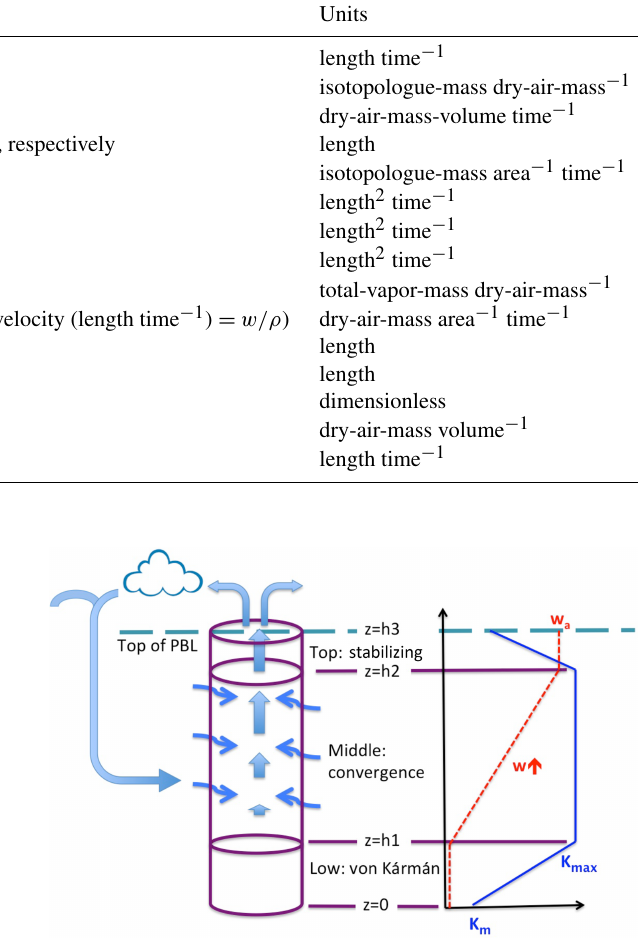
Figure 1. Cartoon of the MBL model. The modeled region is in- dicated by the cylinder. It is comprised of three layers – the low von Kármán layer, the middle convergence layer, and the top stabi- lizing layer. The heavy straight arrows represent the flow of semi- moist air ascending through the middle and top layers and through the top of the MBL into the free atmosphere (above the model) where clouds and precipitation may form, after which some de- pleted air from the model column or elsewhere sinks and mixes into the MBL and converges into the middle layer of the model (thin wiggly arrows). Vapor is advected by the vertical motion of air in the middle and top layers and is transported by vertical (diffusive) mixing in all three layers. To the right are graphs of w(z) (dashed red) and K(z) (solid blue) as they vary through the three